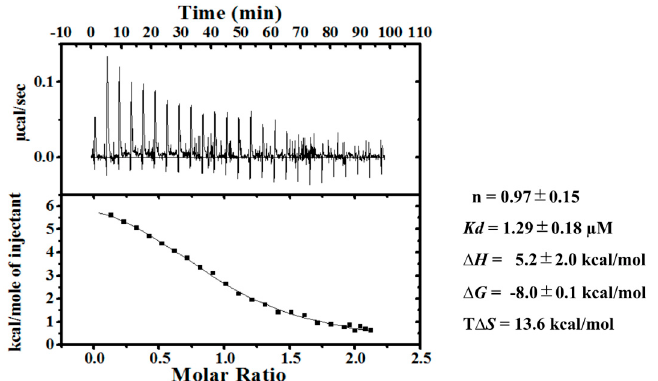
Figure 9. ITC measurements for the interactions between SOUL1-143 and delta3-23 ALG-2 WT . Typical calorimetric titrations (upper panel) and the resulting integrated binding isotherm (lower panel) at 25 °C and pH 7.5 in the presence of 15 µM Ca 2+ . The thermodynamic parameters were obtained from the analysis of three-independent ITC data.